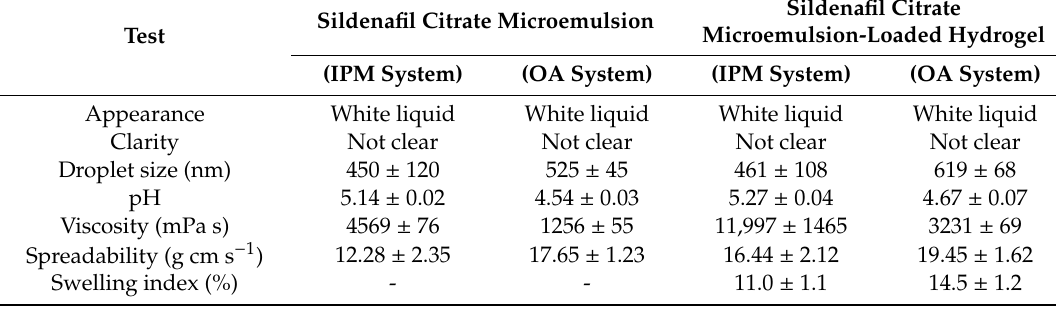
Table 4. Physical properties of the microemulsion systems and sildenafil citrate microemulsion-loaded hydrogel formulations.